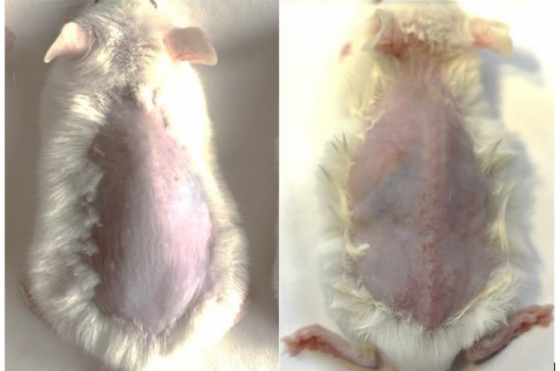
Figure 1. External signs of chronic exposure to UVA in an ICR mouse from the photoaging group (week 12 of the experiment, left ) compared to the same animal prior to the experiment ( right